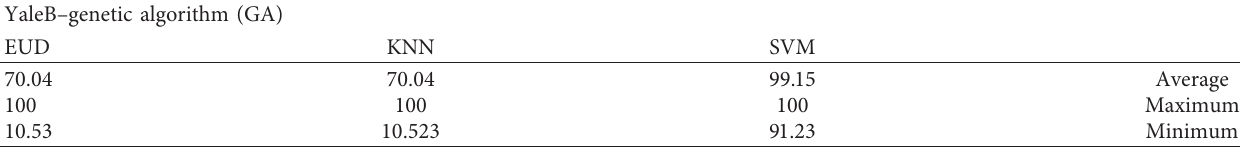
Table 3: Recognition accuracies for the YaleB database with the GA algorithm.